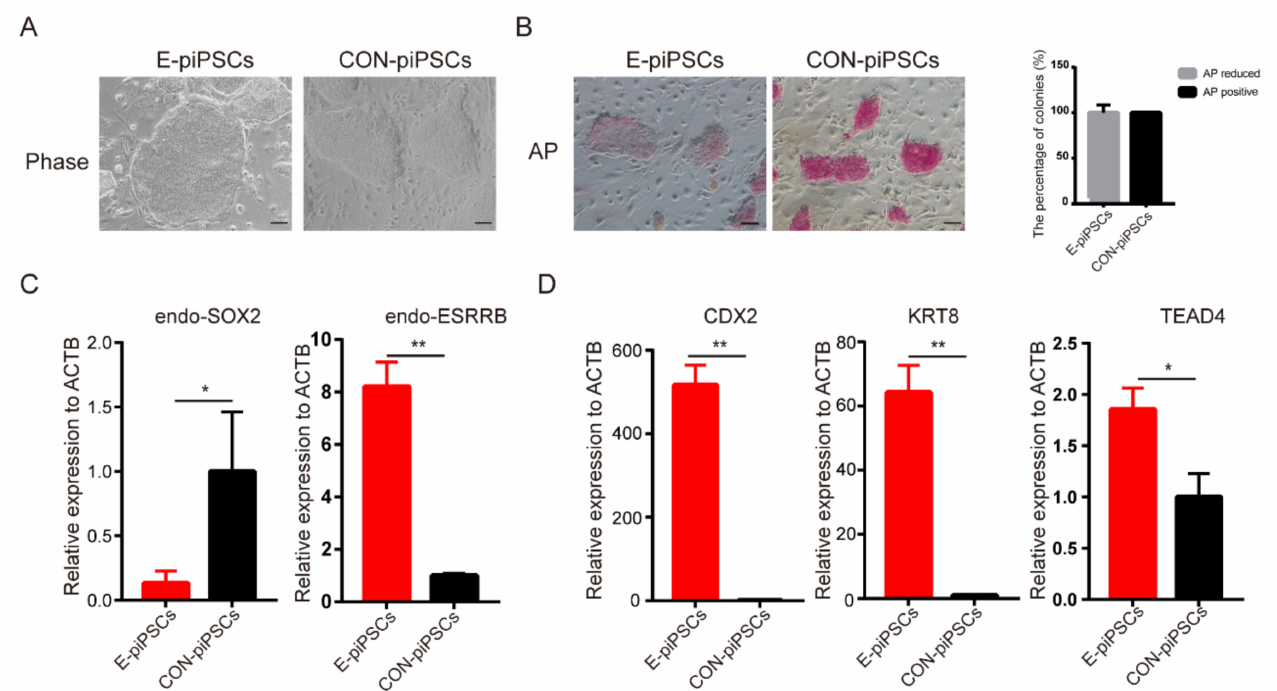
Figure 1. Characterization of E-piPSCs and CON-piPSCs. ( A ) Representative image of bright field of the CON- and ESRRB-overexpressing piPSCs (E-piPSCs); the scale bar represents 100 µ m. ( B ) AP staining and qualities analysis of the CON and E-piPSCs; the scale bar represents 100 µ m. ( C , D ) qRT- PCR analysis of the expression levels of pluripotent ( SOX2 , ESRRB ) and trophoblast ( CDX2 , KRT8 and TEAD4 ) markers in the CON- and E-piPSCs. * represents p < 0.05 and ** represents p < 0.001.